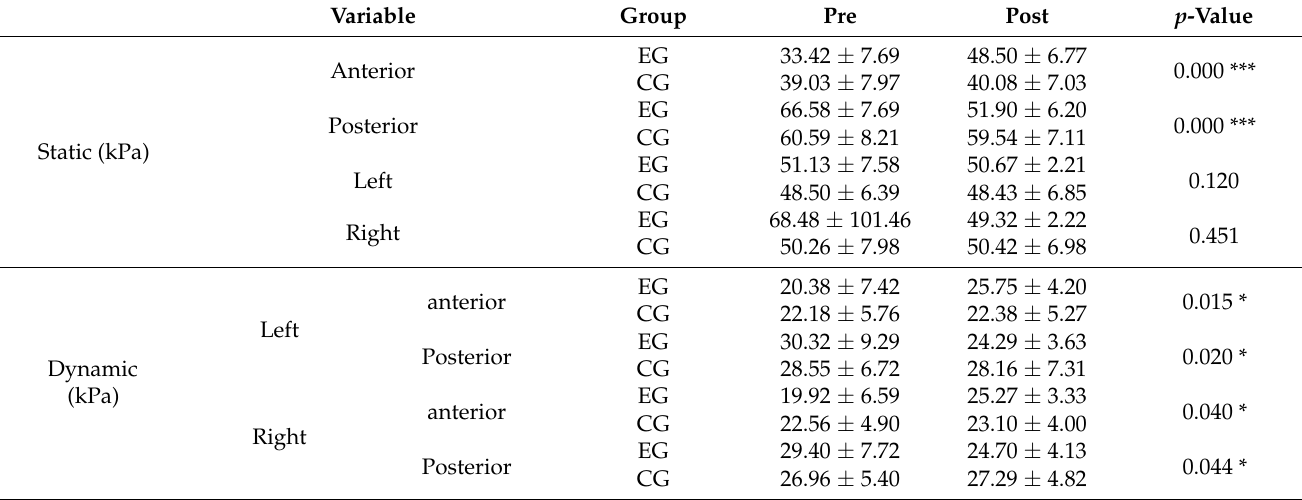
Table 4. Result of changes in structural